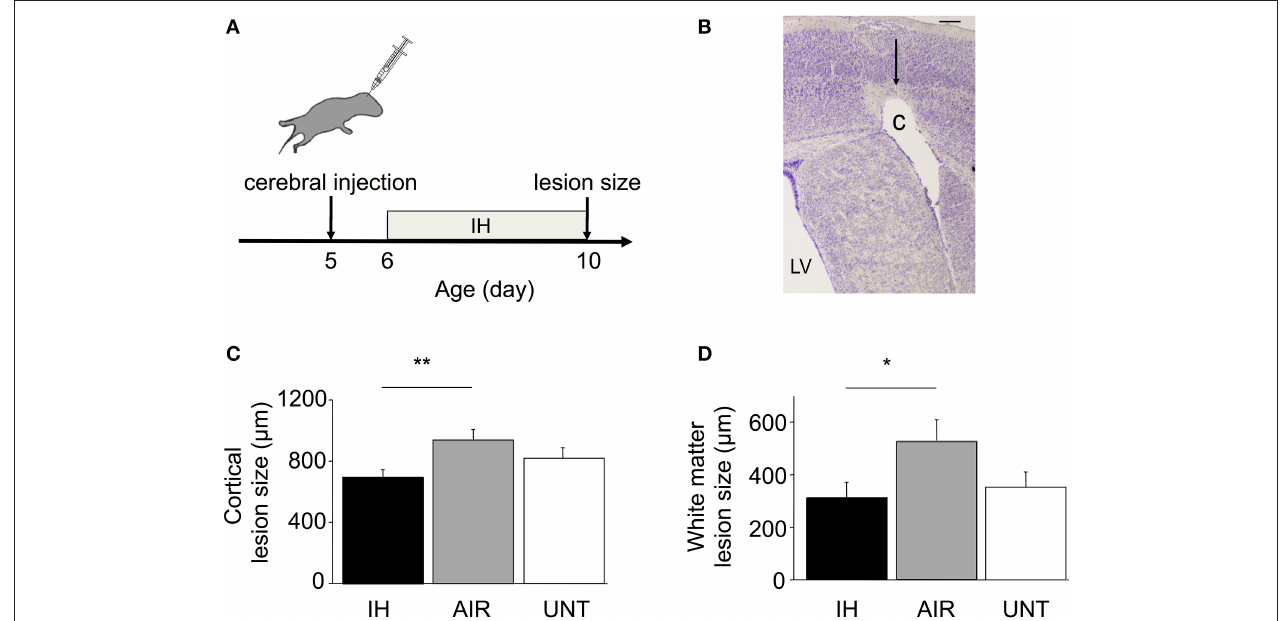
FIGURE 6 | Neuroprotection by IH in mice with excitotoxic brain lesions. (A) Excitotoxic brain lesions were produced by intracerebral injections of ibotenate, a glutamate analog, on P5 in mice exposed to IH ( n = 22 ), exposed to AIR ( n = 21 ), or untreated and left with their dams (UNT, n = 22 ). (B) Coronal section of the right hemisphere showing a lesion. The brains were dissected on P10, after the end of IH exposure, and stained with cresyl violet. Ibotenate injection typically produced neuronal loss in layers III to VI (arrow) and white-matter cystic lesions (C) . LV, lateral ventricle. Scale bar = 40 µ m. (C,D) Cortical and white matter lesion sizes were smaller in IH pups compared to AIR pups. Values are group means ± SEM. * p < 0.05 , ** p < 0.01 .